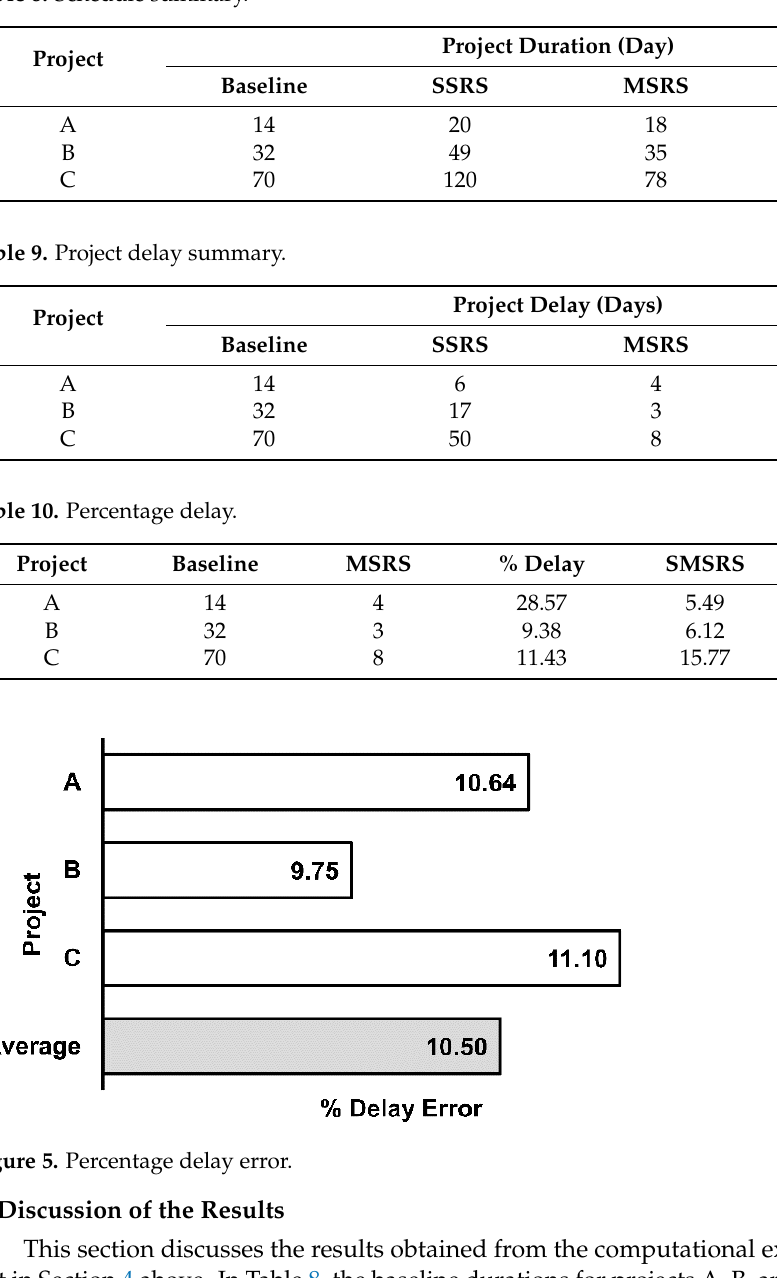
Table 8. Schedule summary.